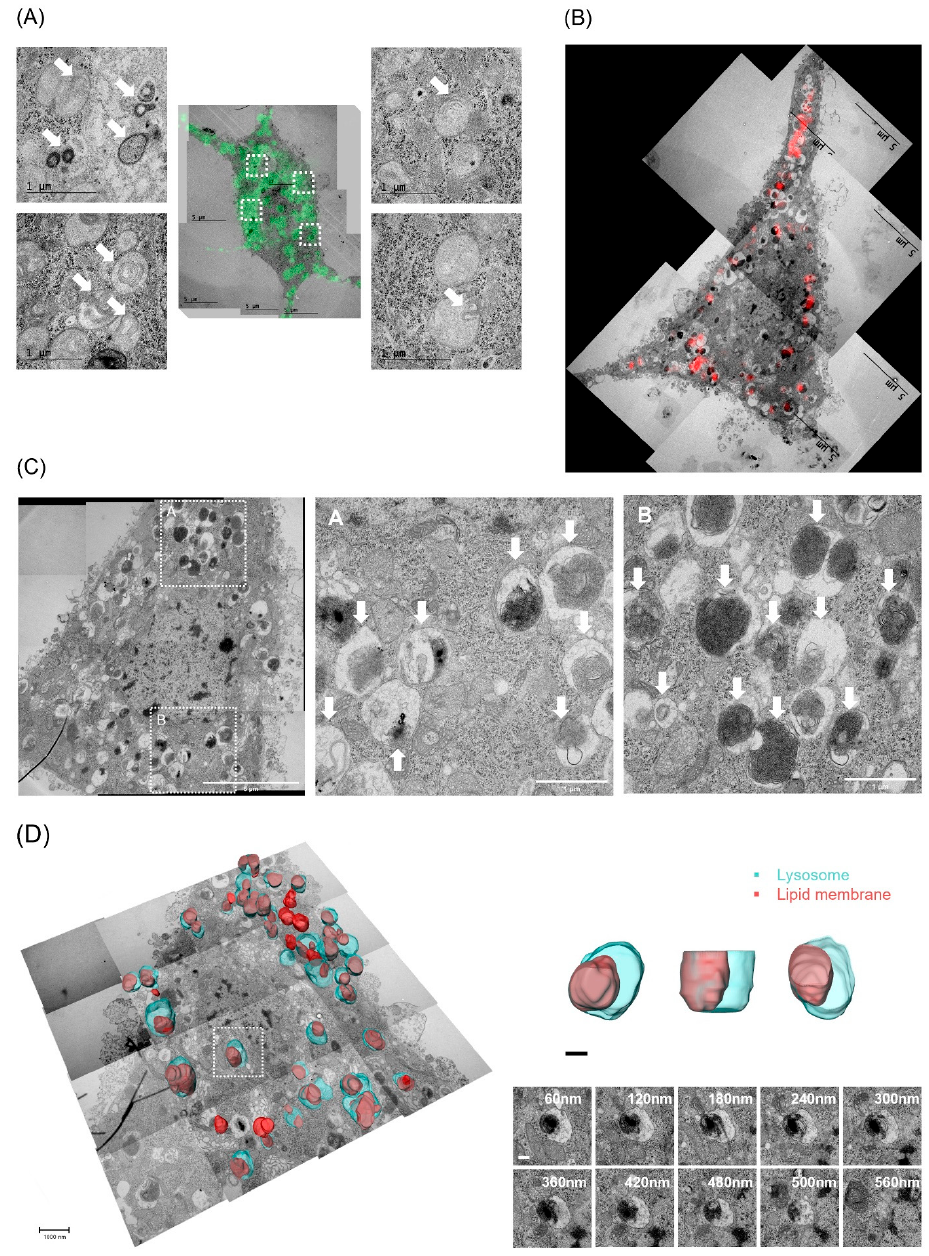
Figure 7. PPA induced lipid membrane accumulation inside the lysosomes in hippocampal neurons. Representative CLEM images of the lamp1 ( A ) or lysotracker ( B ) in PPA-treated hippocampal neurons. The white arrow indicates the lipid membrane accumulation inside the lysosomes. Scale bar, 1 µ m (left); 5 µ m (right). ( C ) Representative TEM images of lipid membrane accumulation inside the lysosomes in the presence of PPA in hippocampal neurons. Scale bar, 5 µ m (left); 1 µ m (the magnified images). The white arrow indicates the lipid membrane accumulation inside the lysosomes. ( D ) Representative 3D volume reconstruction images in PPA-treated hippocampal neurons. Aqua color, lysosome; crimson color, lipid membrane accumulation. Scale bar, 1 µ m (left); 200 nm (right); 100 nm